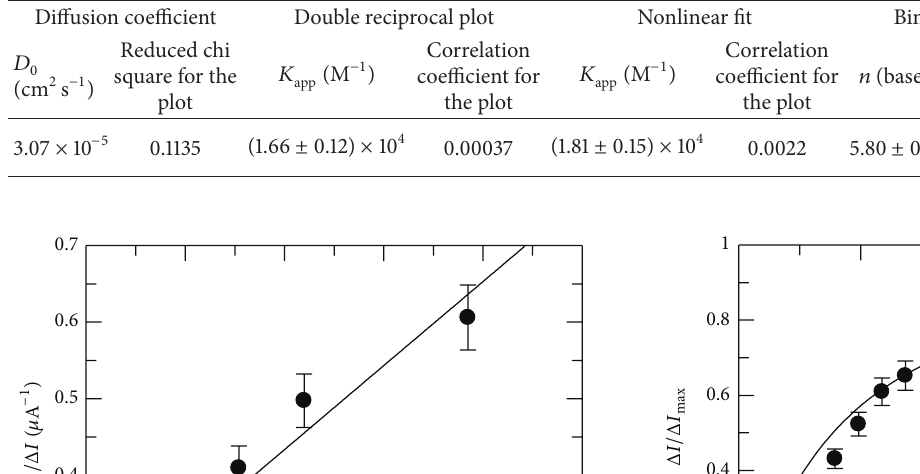
Table 2: Evaluated electrochemical parameters, binding parameters, reduced chi square, and correlation coefficient for the plots.